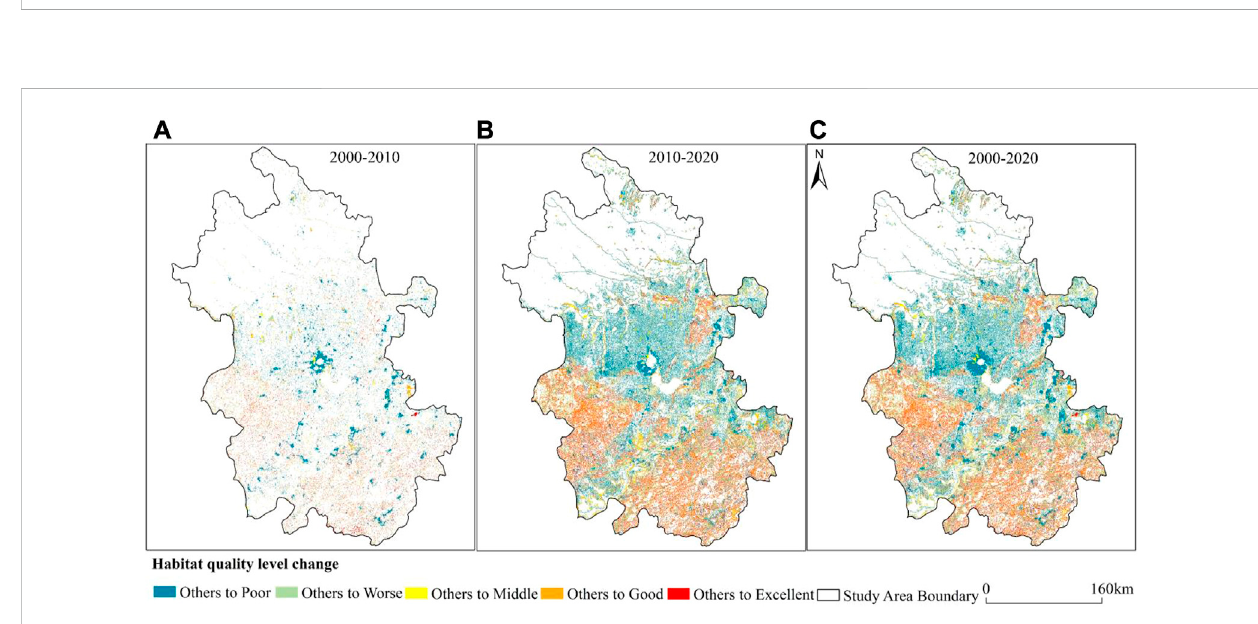
FIGURE 8 Habitatqualitytransferintheperiod2000 – 2020. (A) 2000Habitatqualitytransfer, (B) 2010Habitatqualitytransfer, (C)